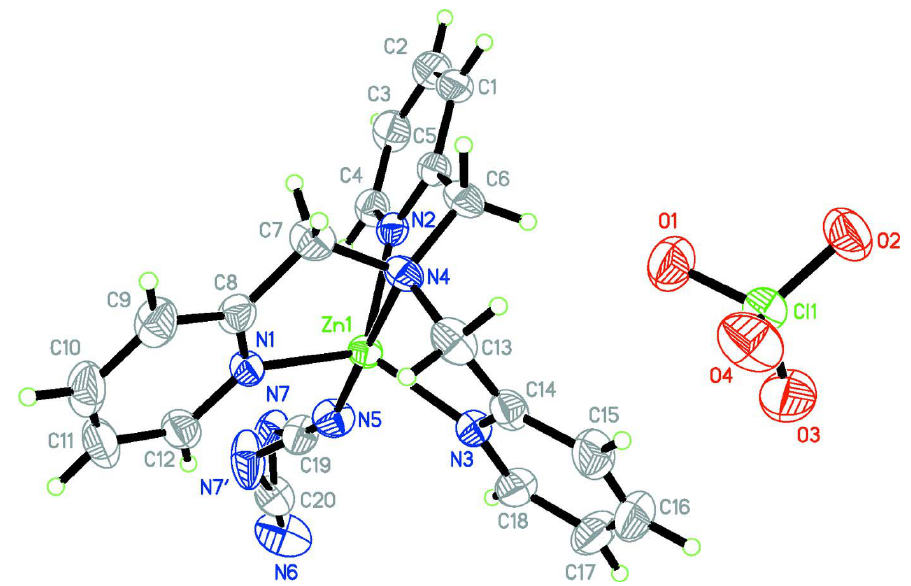
Figure 1 View of complex (I), showing the the atom numbering scheme with thermal ellipsoids drawn at the 30% probability level.